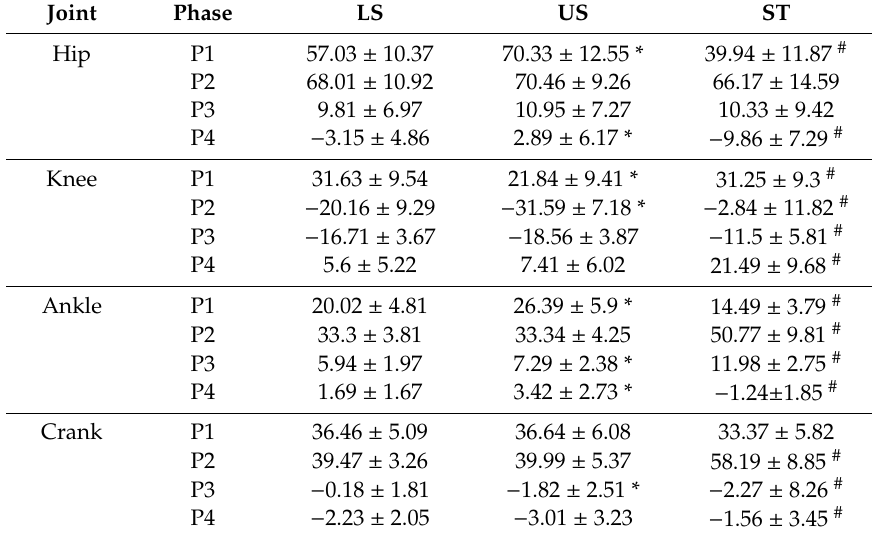
Table 1. Mean moments ( ± SD) of the hip, knee, and ankle joints, and the crank in LS, US, and ST conditions from P1 to P4 at a constant power output (N · m). Joint Phase LS US ST